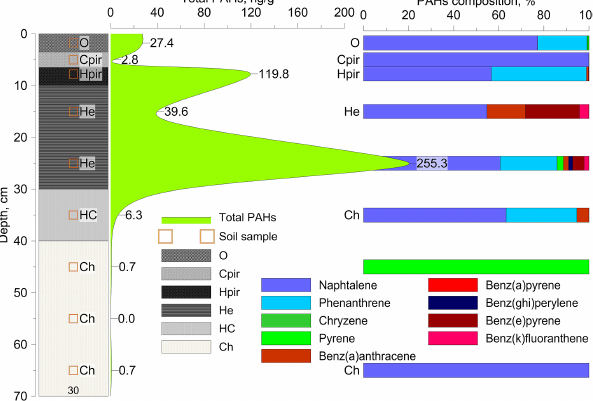
Figure 6. The profile distribution and composition of PAHs in post- fire histosol in the case of a thick organogenic horizon (pit 9).